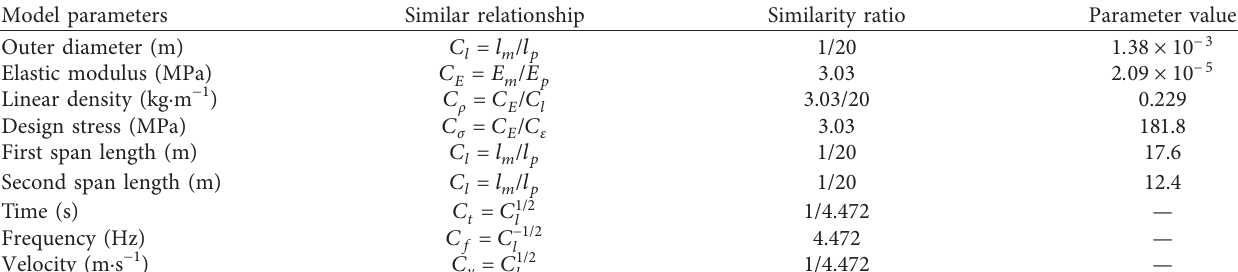
Table 1: Similarity ratio and values of model parameters.